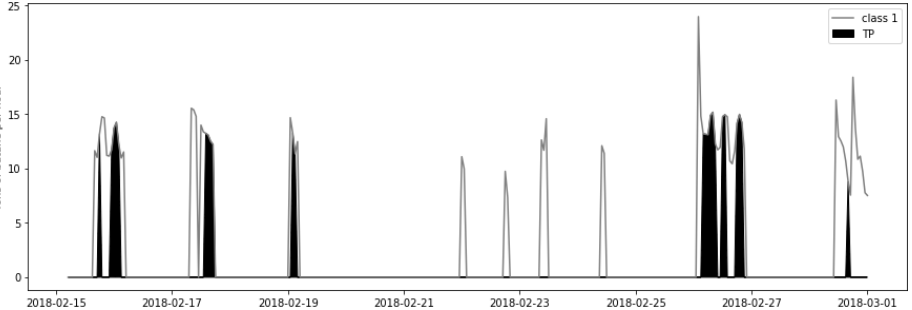
Figure 13. Tons of butane per hour that do not fulfil the specification